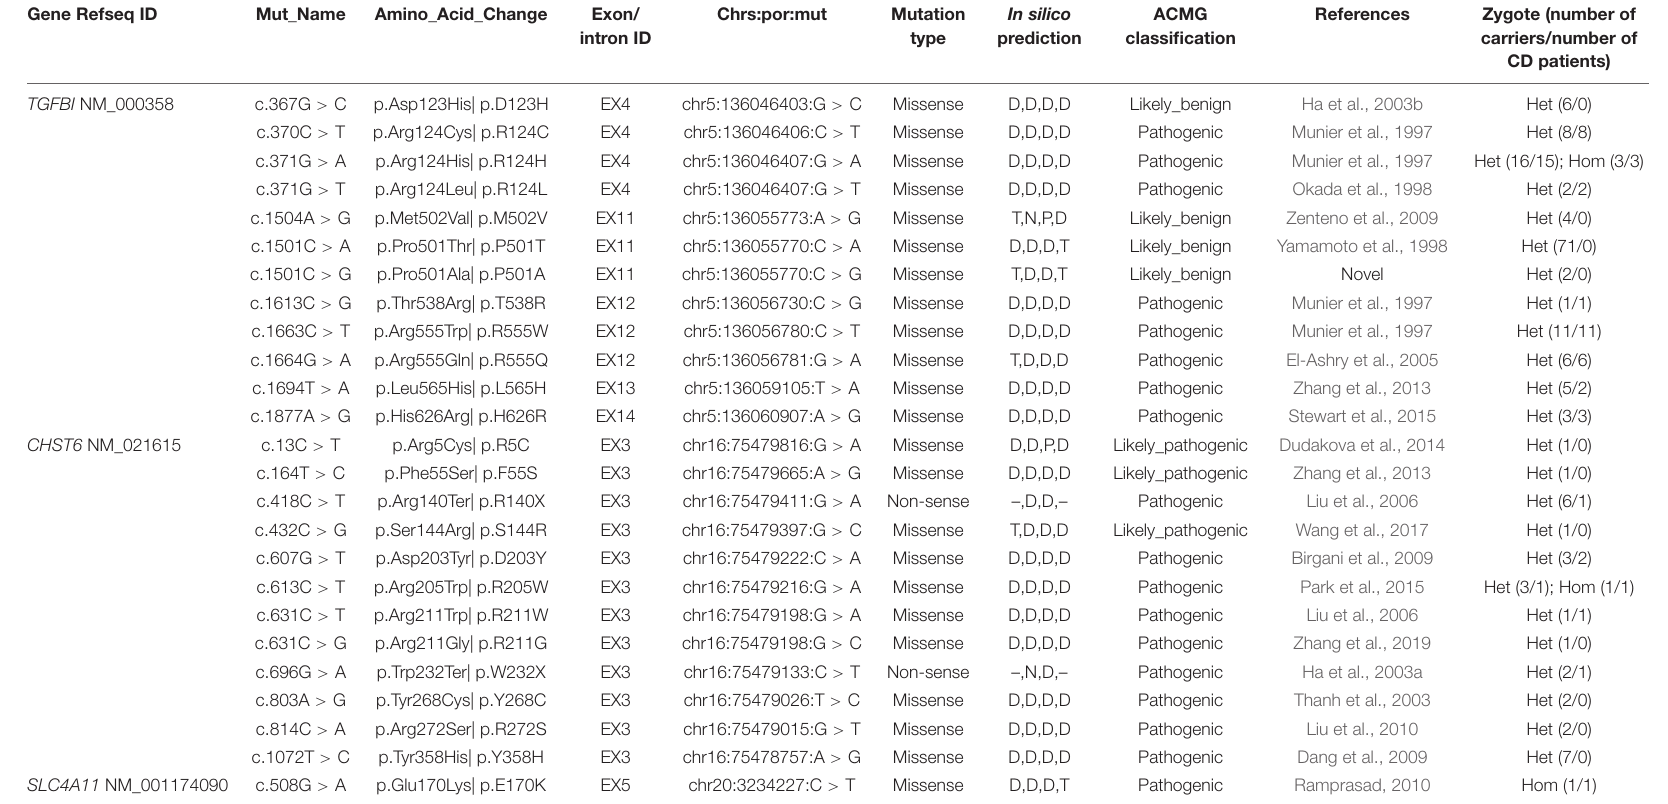
TABLE 1 | Variations included in HGMD or ClinVar or previously reported were identified in this